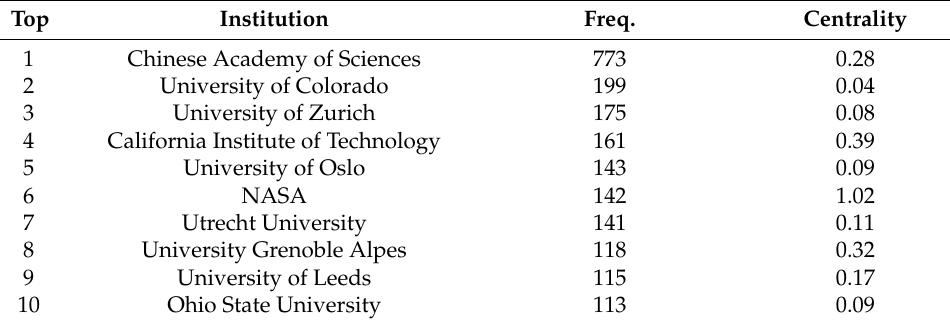
Figure 7. Knowledge map of institution collaboration. Table 6. Top ten institutions by number of